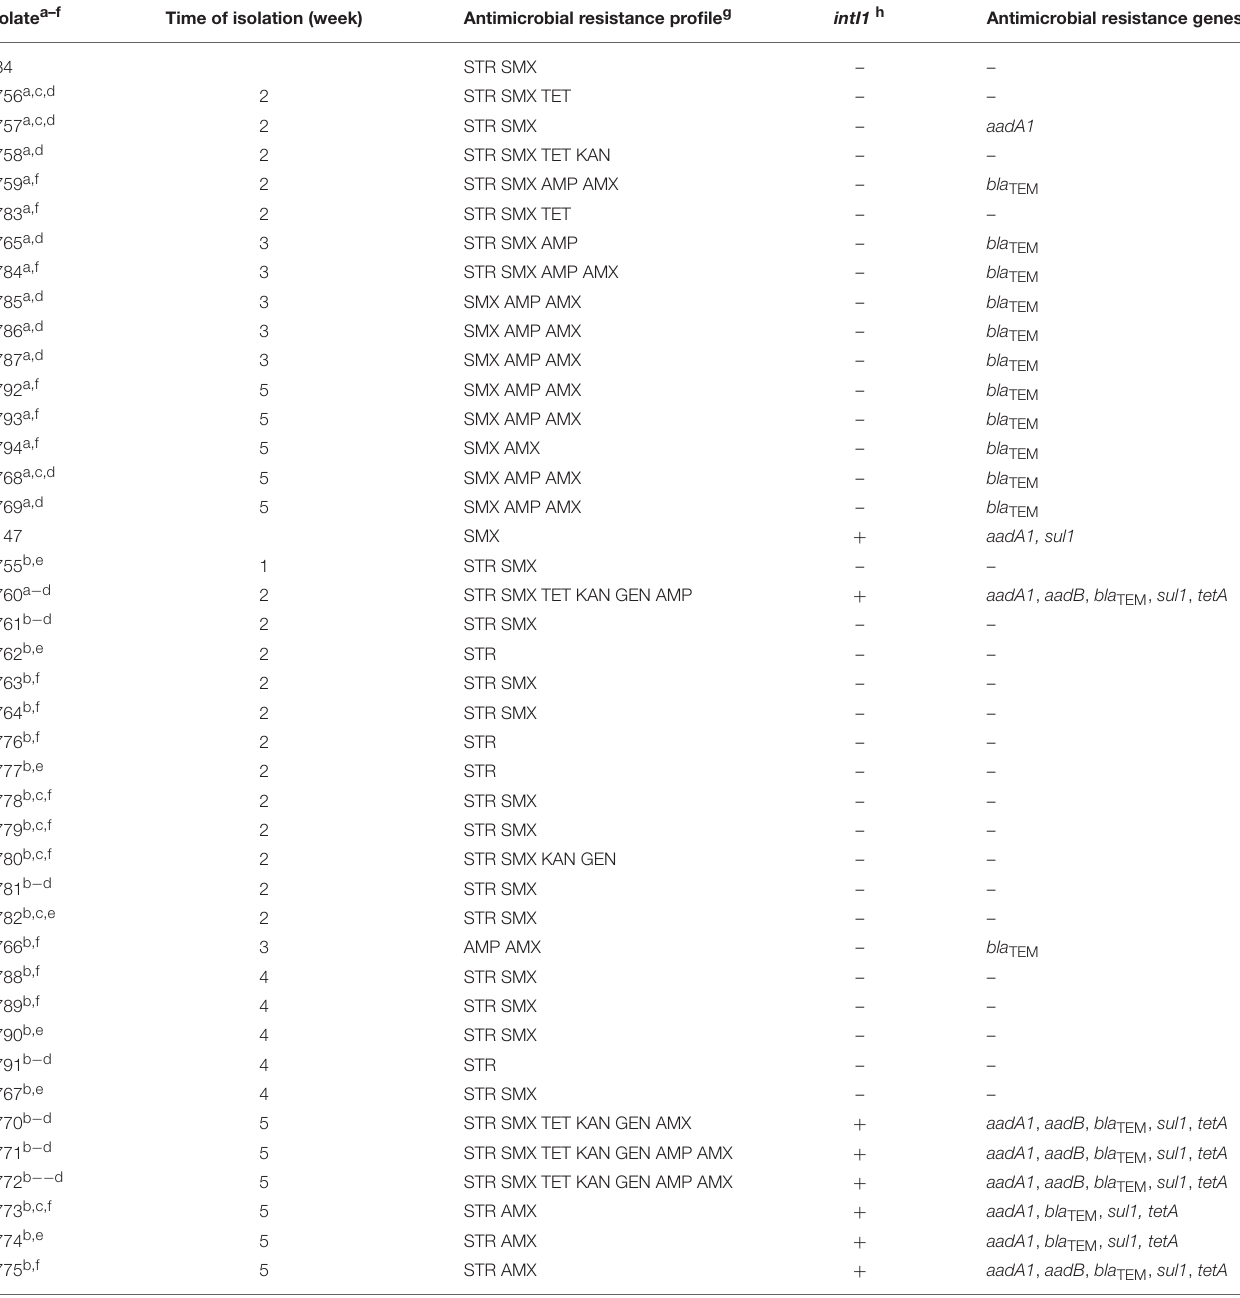
TABLE 11 | Antimicrobial resistance genotype and phenotypes of S. Typhimurium recovered from poultry environment of chickens experimentally colonized with Salmonella